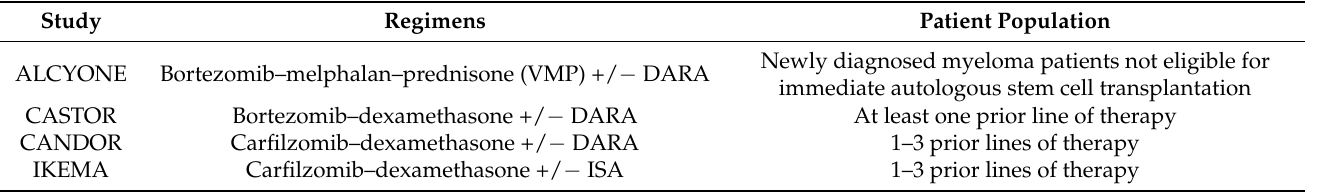
Table 2. Selected phase 3 studies evaluating proteasome inhibitor-based antibody